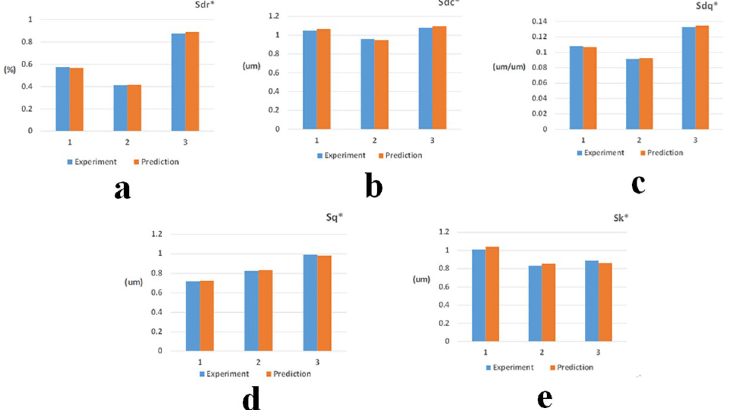
Fig 12. Verification of model prediction. (a) Sq � . (b) Sdc � . (c) Sdq � . (d) Sdr � . (e) Sk � .